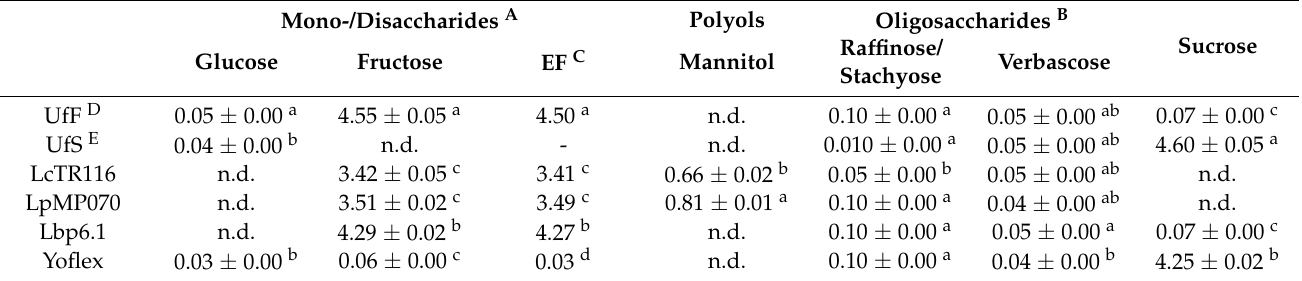
Table 5. Content of FODMAPs and sucrose as measured by HPAEC-PAD, in g/100 g. Mono-/Disaccharides A Polyols Oligosaccharides B Sucrose Raffinose/ Verbascose Glucose Fructose EF C Mannitol Stachyose UfF D 0.05 ± 0.00 a 4.55 ± 0.05 a 4.50 a n.d. 0.10 ± 0.00 a 0.05 ± 0.00 ab 0.07 ± 0.00 c n.d. - n.d. 0.010 ± 0.00 a 0.05 ± 0.00 ab 4.60 ± 0.05 a 0.81 ± 0.01 a n.d.